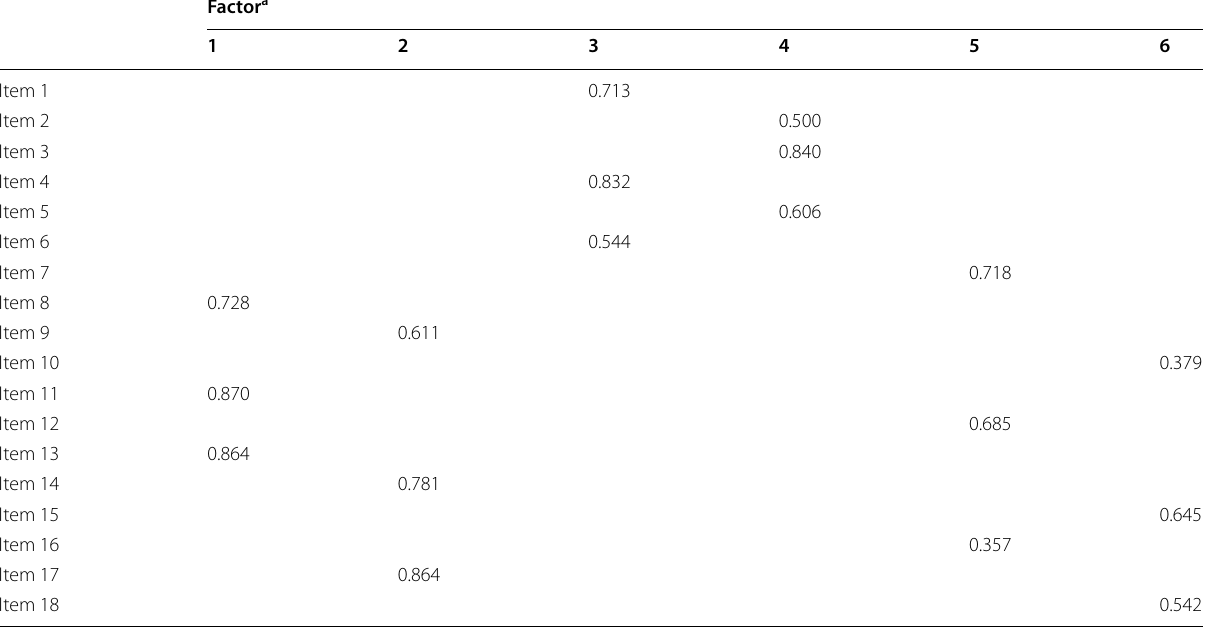
Table 1 Pattern matrix: factor loadings < 0.35 suppressed